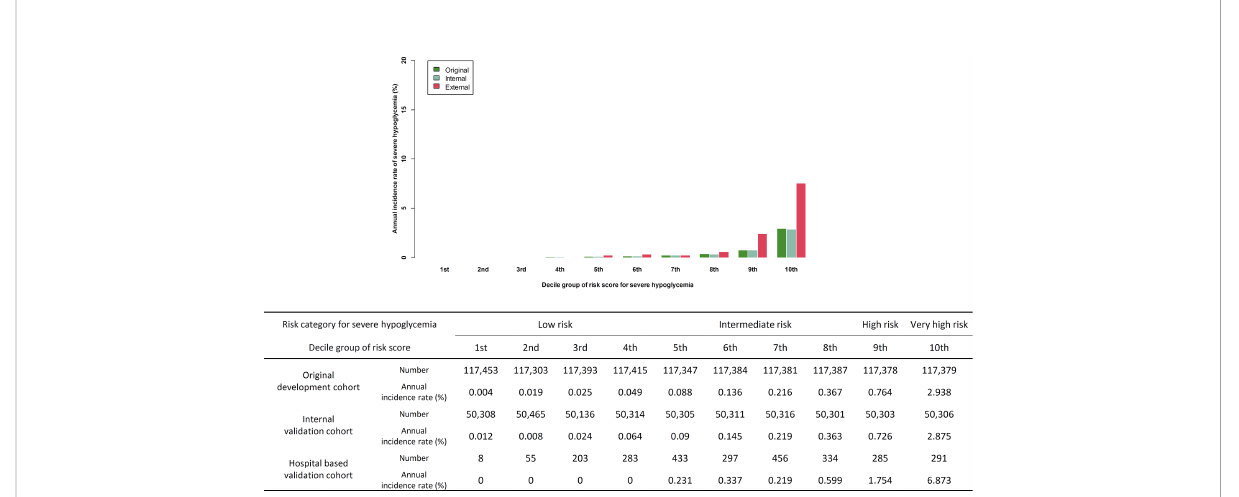
FIGURE 1 Comparison of predicted incidence rate per 1,000 person-year in development cohort and actual incidence rate in internal validation cohort and external validation cohort.